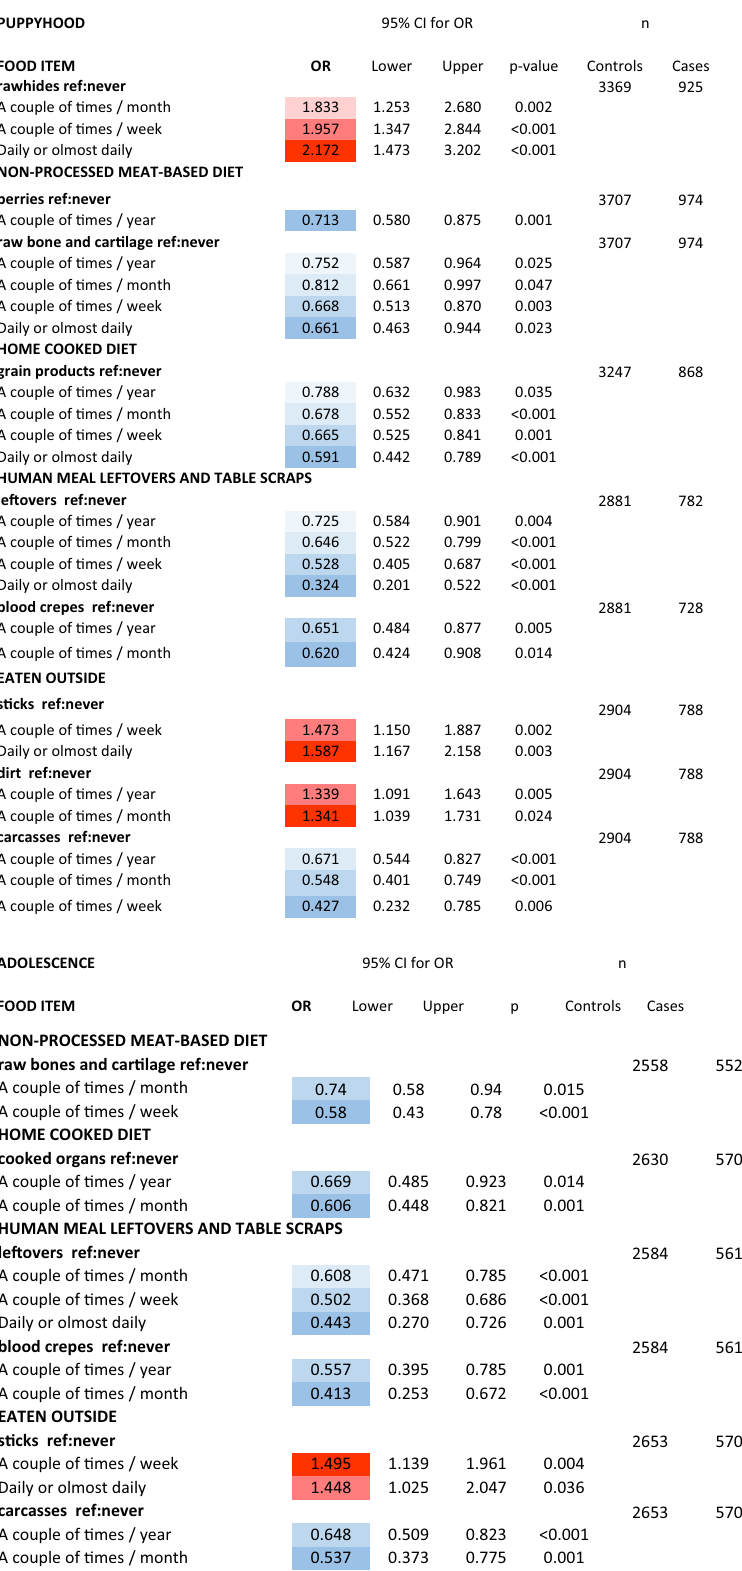
Table 4. Odds ratios (OR) of the significant ( p < 0.05) associations of food items within puppyhood or adolescent diet style and chronic enteropathy (CE) later in life, based on multivariate logistic regression analyses (adjusted for dog gender). The OR cells are colored based on the values to ease reading and highlight the effect direction (red = increased risk, blue = protective effect) and increase in the effect size with increasing feeding frequency. CI = confidence interval, ref =